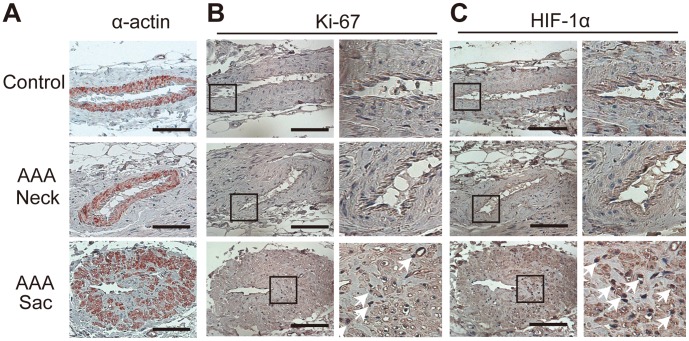
Immunohistological study of adventitial vasa vasorum (VV).(A) Immunostaining of SMCs in VV expressing alpha smooth muscle actin. Scale bar = 100 μm. (B) Immunostaining of cell proliferation marker (Ki-67) in VV. Scale bar = 20 μm. (C) Immunostaining of hypoxic inducible factor-1α (HIF-1α) in VV. Scale bar = 20 μm.